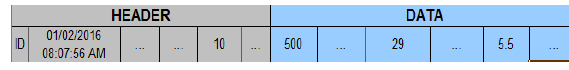
Figure 11. Exampleof a piece of spatial-temporal